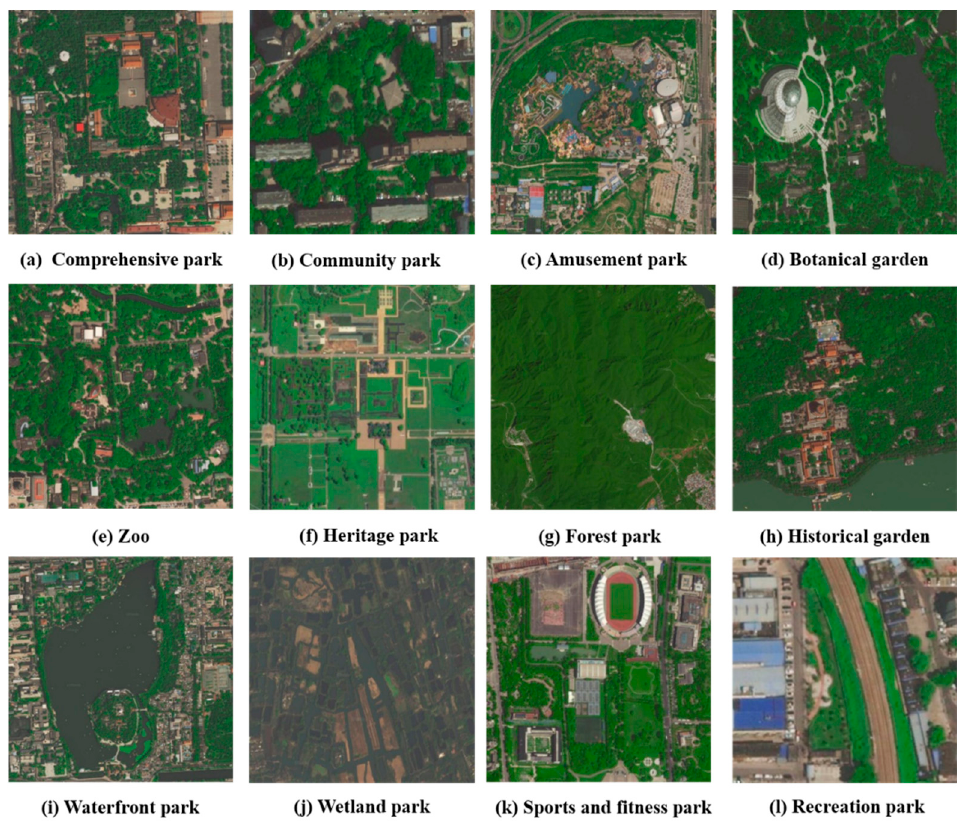
Figure 1. Various types of parks in satellite images of Beijing ( a – l ).